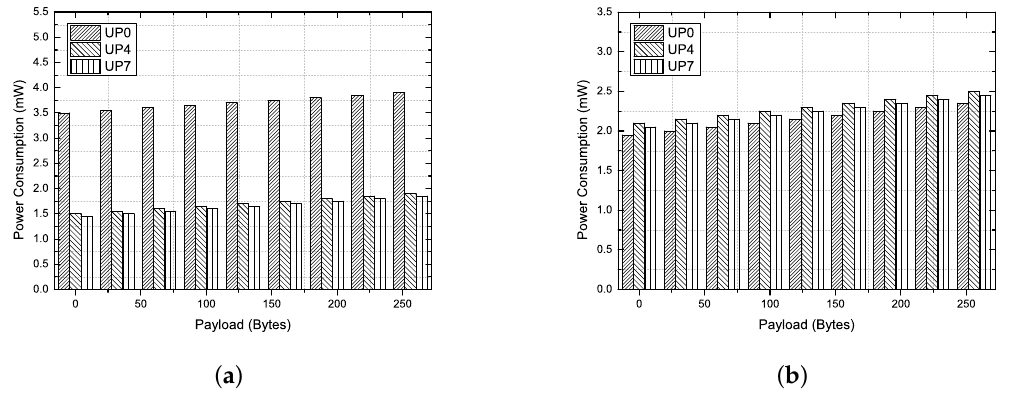
Figure 17. Performance comparison for different payloads in scenario 3: Impact of varying payloads on average power consumption in the ( a ) one- and ( b ) two-hop star